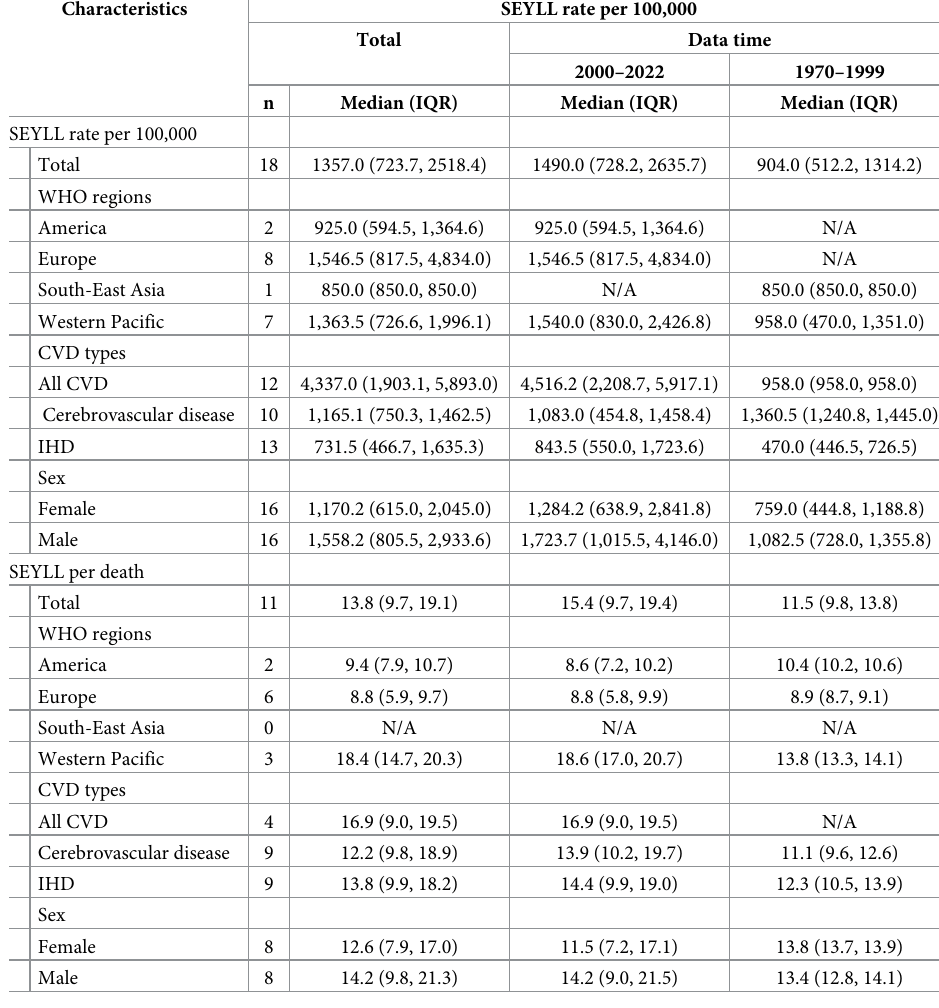
Table 4. Summary of total standard expected years of life lost (SEYLL), from CVD mortality method from GBD study (1996) according to study characteristics.